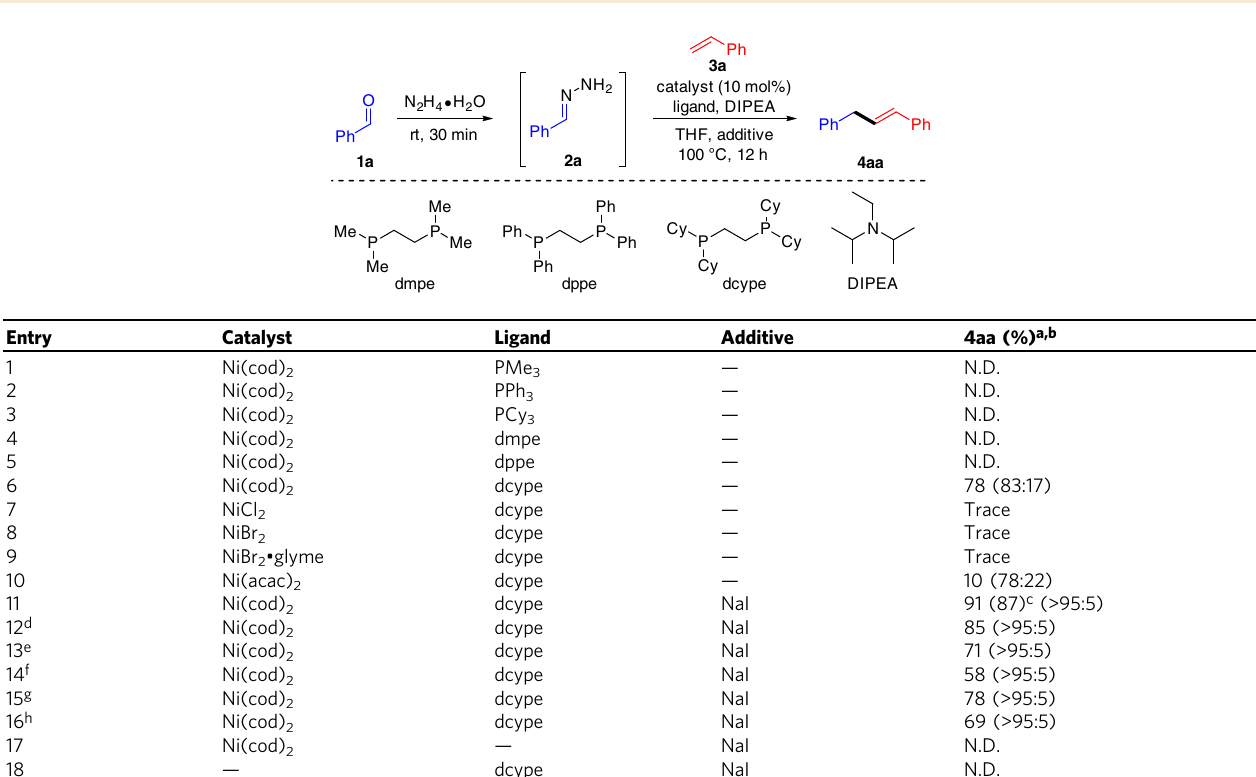
Table 1 Optimization of the reaction conditions